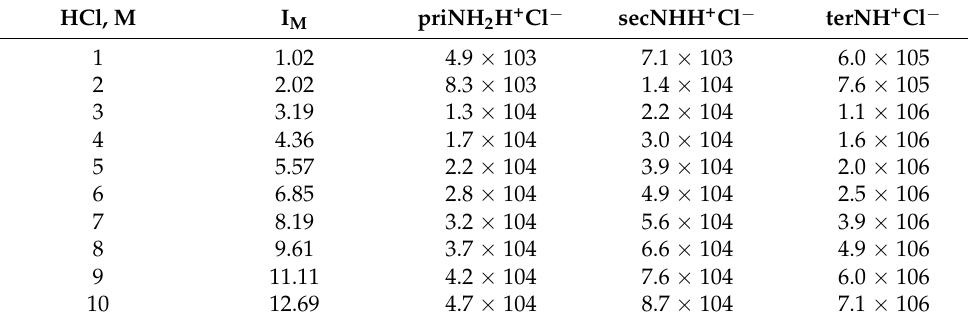
Table 3. Values of K ext at various HCl